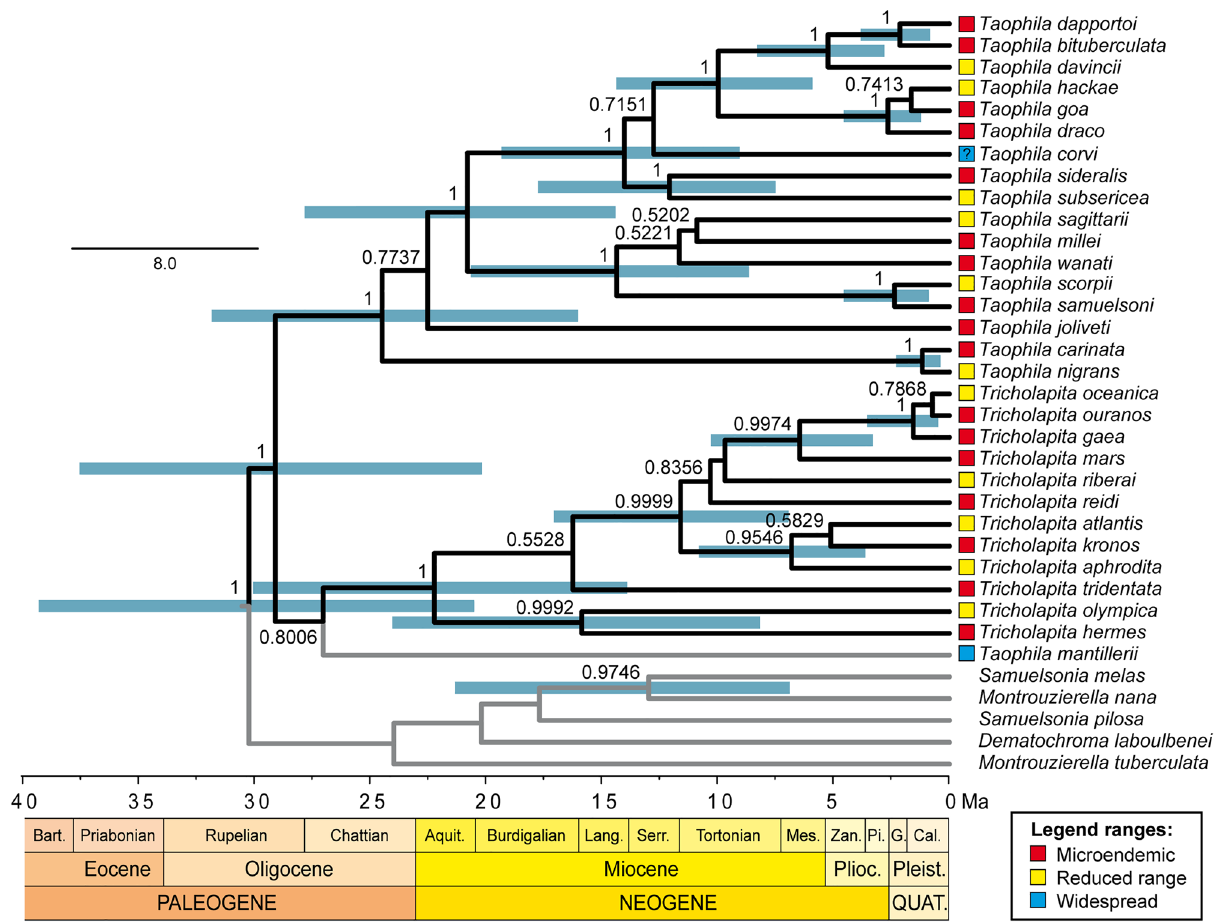
Figure 1. Uncorrelated-lognormal clock-constrained tree of New Caledonian Eumolpinae, with focal groups Taophila and Tricholapita highlighted. Moderately (posterior probability [PP] = 0.50–0.95) and highly (PP = 0.95–1.00) supported nodes are labelled and the HPD age intervals of the latter represented by bars for each of the nodes. Terminals colour-coded according to accompanying legend based on known species distributions, where “microendemic” refers to species known from a single or geographically close localities; “reduced range” to species found in a regional set of localities; and “widespread” to species found across Grande